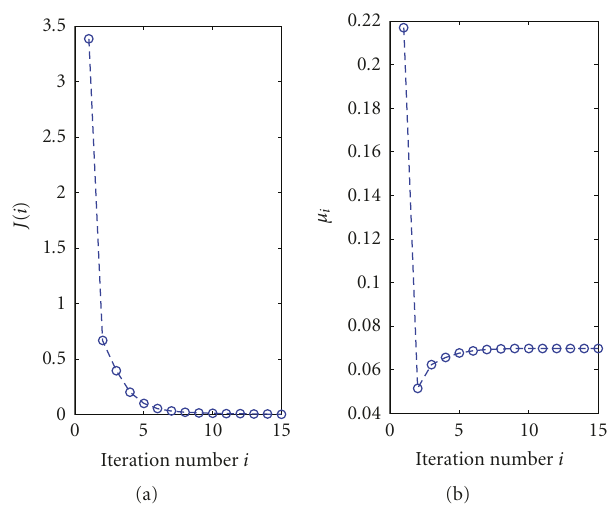
Figure 7: The convergence of the proposed precoder design algorithm (8-PSK system in Figure 6 and E s /N 0 = 2 dB). Left: versus iteration number; Right: variation of J ( i ) = (cid:6) F i − F i − 1 (cid:6) 2 F variation of μ i with iteration number.